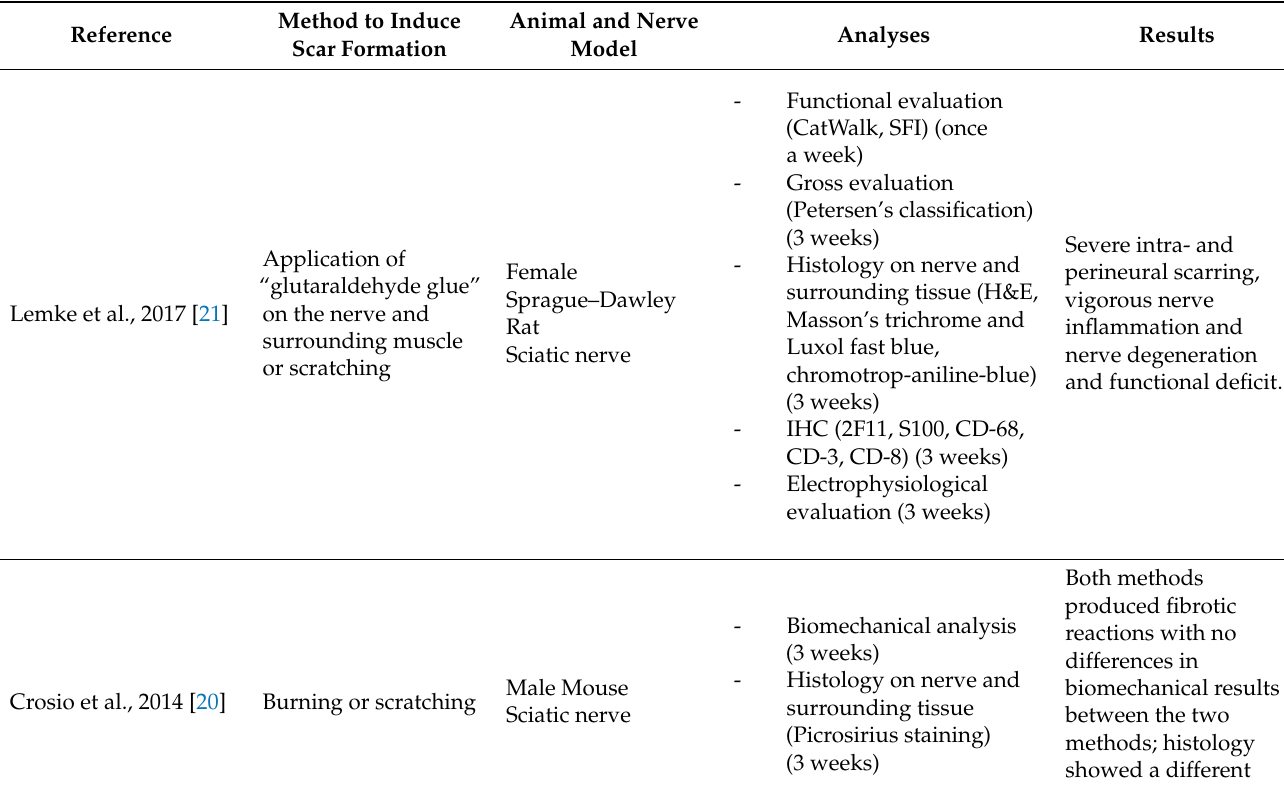
Table 1. No antiscarring agents